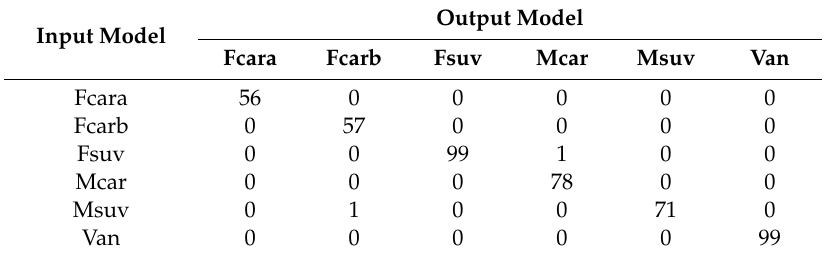
Table 2. The total confusion matrix for the recognition results of the trainning set in an